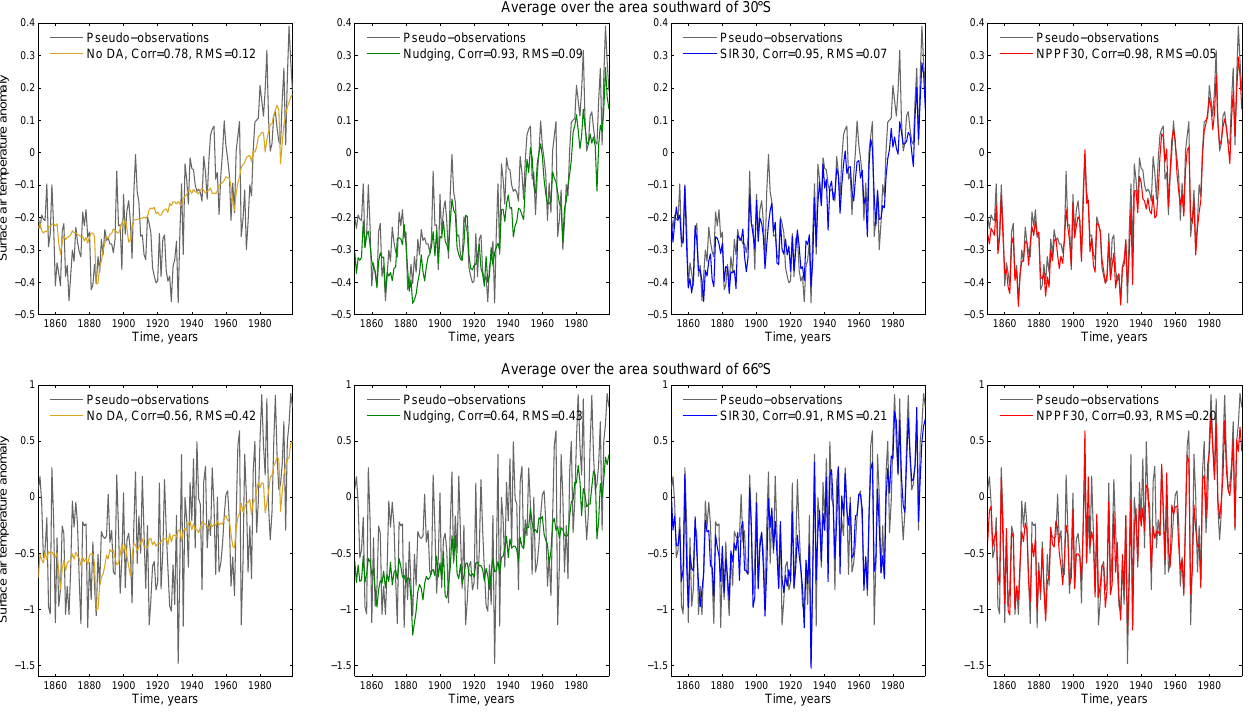
Fig. 1. Reconstructions of surface air temperature anomalies ( ◦ C) averaged over the area southward of 30 ◦ S (top panel) and over the area southward of 66 ◦ S (bottom panel), when the dense pseudo-observations are assimilated. Gray line: pseudo-observations; yellow line: model simulations without data assimilation; green line: the nudging; blue line: the sequential importance resampling applied over the polar cap southward of 30 ◦ S; red line: the nudging proposal particle filter applied over the polar cap southward of 30 ◦ S. Correlations and the RMS errors are displayed in upper left corners.